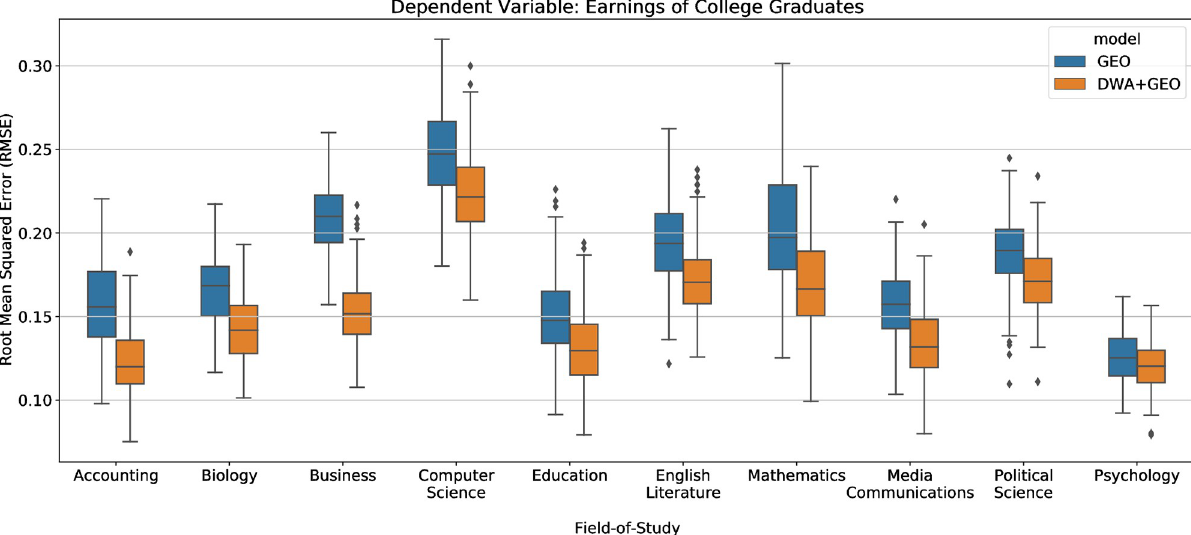
Fig 6. Workplace activities detected from syllabi predicting median first-year earnings of college graduates within a field of study. We perform 5-fold cross validation and repeat 40 times (i.e., 200 trials in total) for each model and measure RMSE by the resulting model applied to the test set. The baseline GEO model only includes geographic variables. The performances of the DWA+GEO models are statistically significantly better than the GEO models with the p-values < 0.05 for all of the reported FOS (the school ranking is omitted due to the limited earnings data).